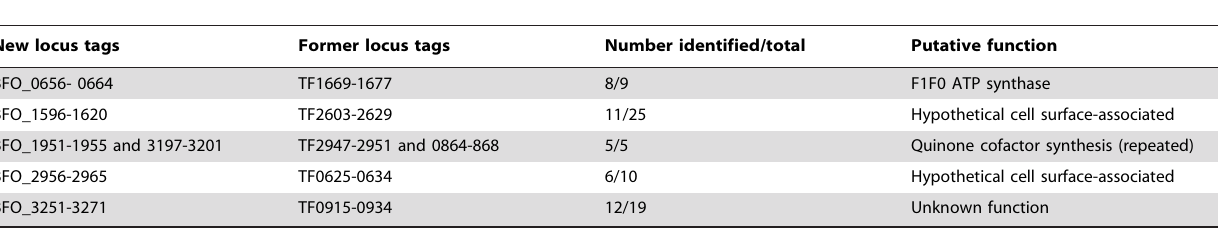
Table 4. Clusters of genes present in T. forsythia and other pathogens but missing from BU063 .